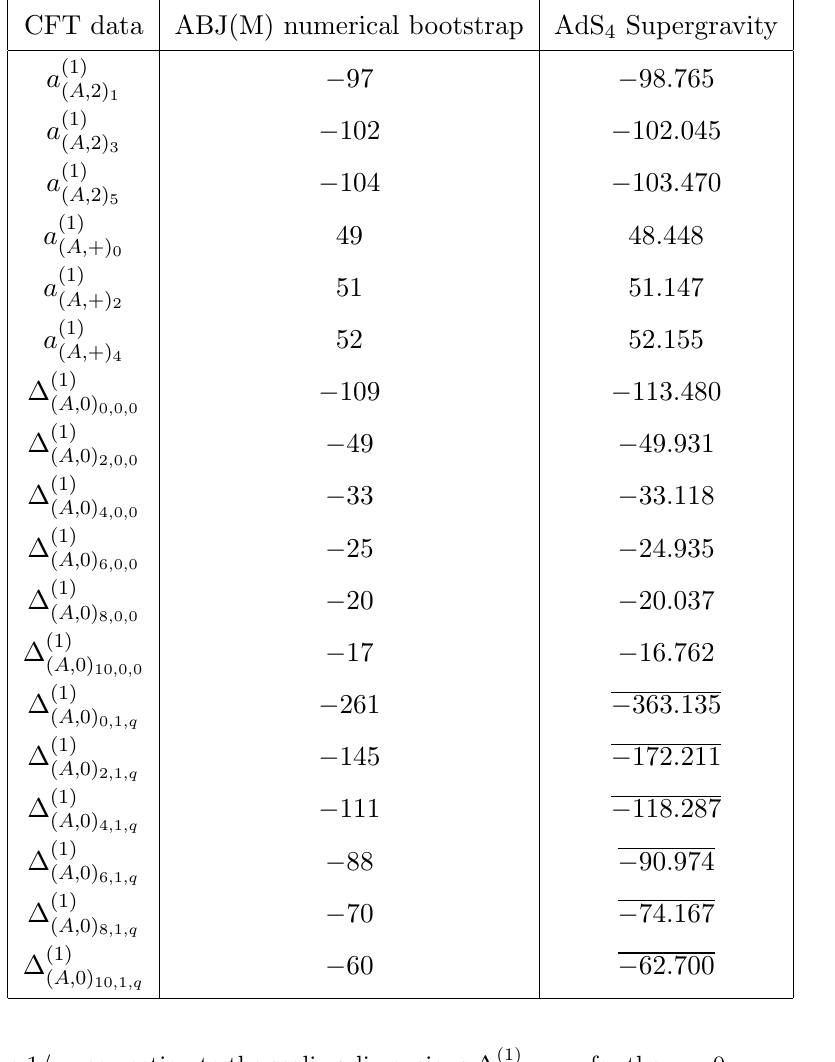
Table 5 . The 1 =c T correction to the scaling dimensions (cid:1) (1) operators with spin j and twist 2 n +2, as well as the OPE coe(cid:14)cients squared a (1) the semi-short operators of spin j , computed from the numerical conformal bootstrap for ABJ(M) in [37] and the supergravity calculation in this work. Exact formulae for supergravity are given in (4.19), (4.22), (4.26), and (4.29). For n > 0, the exact results refer to averages over n +1 distinct operators with the same quantum numbers, as denoted by the overline, while the bootstrap results refers to the lowest of these mixed